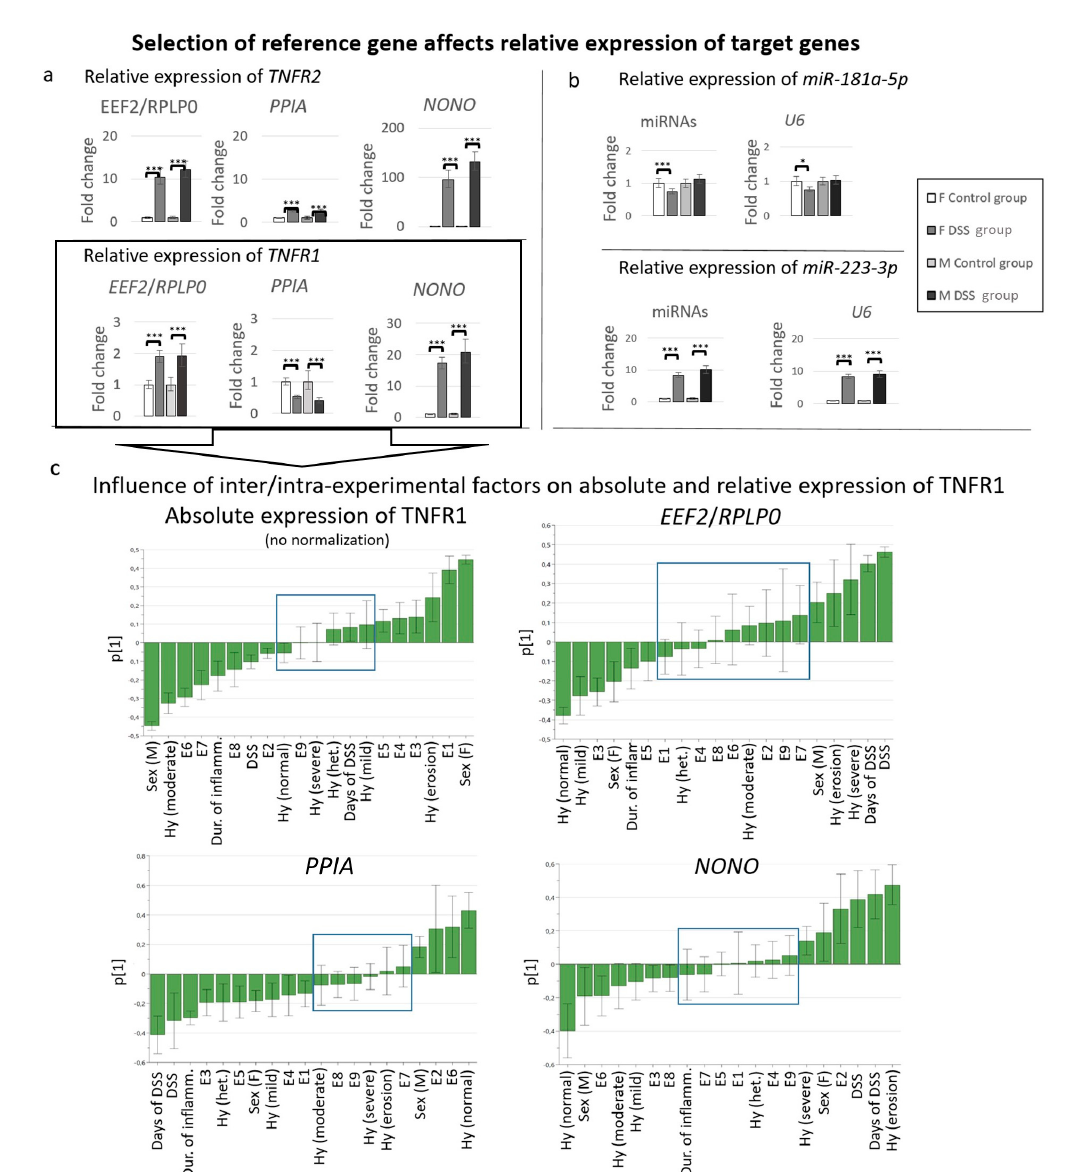
Figure 4. Selection of reference genes affects relative expression levels of target genes and the impact of inter/intra-experimental factors on target gene expression in archived FFPE samples of control and DSS-treated C57BL6/JOlaHsd mice (females and males). ( a, b ) Graphs present relative expres- sion level of ( a ) TNFR1 and TNFR2, ( b ) miR-181a-5p and miR-223p ( a ) normalized to the most (EEF2/RPLP0) and to the least stable (PPIA and NONO) mRNA reference genes and ( b ) to the most (miR-191-5p/miR-103a-3p/miR-16-5p) and to the least stable (U6) miRNA reference genes, respectively. Different normalization led to significant differences. ( c ) Graphs represent influence of inter/intra-experimental factors on absolute (no normalization) and relative expression levels of TNFR1 (normalized to the combination of reference genes EEF2/RPLP0, and PPIA and NONO). Normalization of TNFR1 reduced the influence of inter/intra-experimental factors on relative expres- sion levels of TNFR1 (factors inside Table 1. The number of inter/intra-experimental factors that do not affect TNFR1 is greater in the case of normalization with the most stable mRNA reference genes (EEF2/RPLP0). Legend: F, female; M, male; E1–E9, experiment number; DSS, DSS treatment applied; duration of inflammation, days/months of water after DSS treatment; Hy, histology; normal, no lesion or inflammation; mild, moderate and severe refer to inflammation; erosion, destruction of epithelial layer of mucosa; heterogeneous, includes both erosion and inflammation. Statistical significance: * p ≤ 0.05, ** p ≤ 0.01, *** p ≤